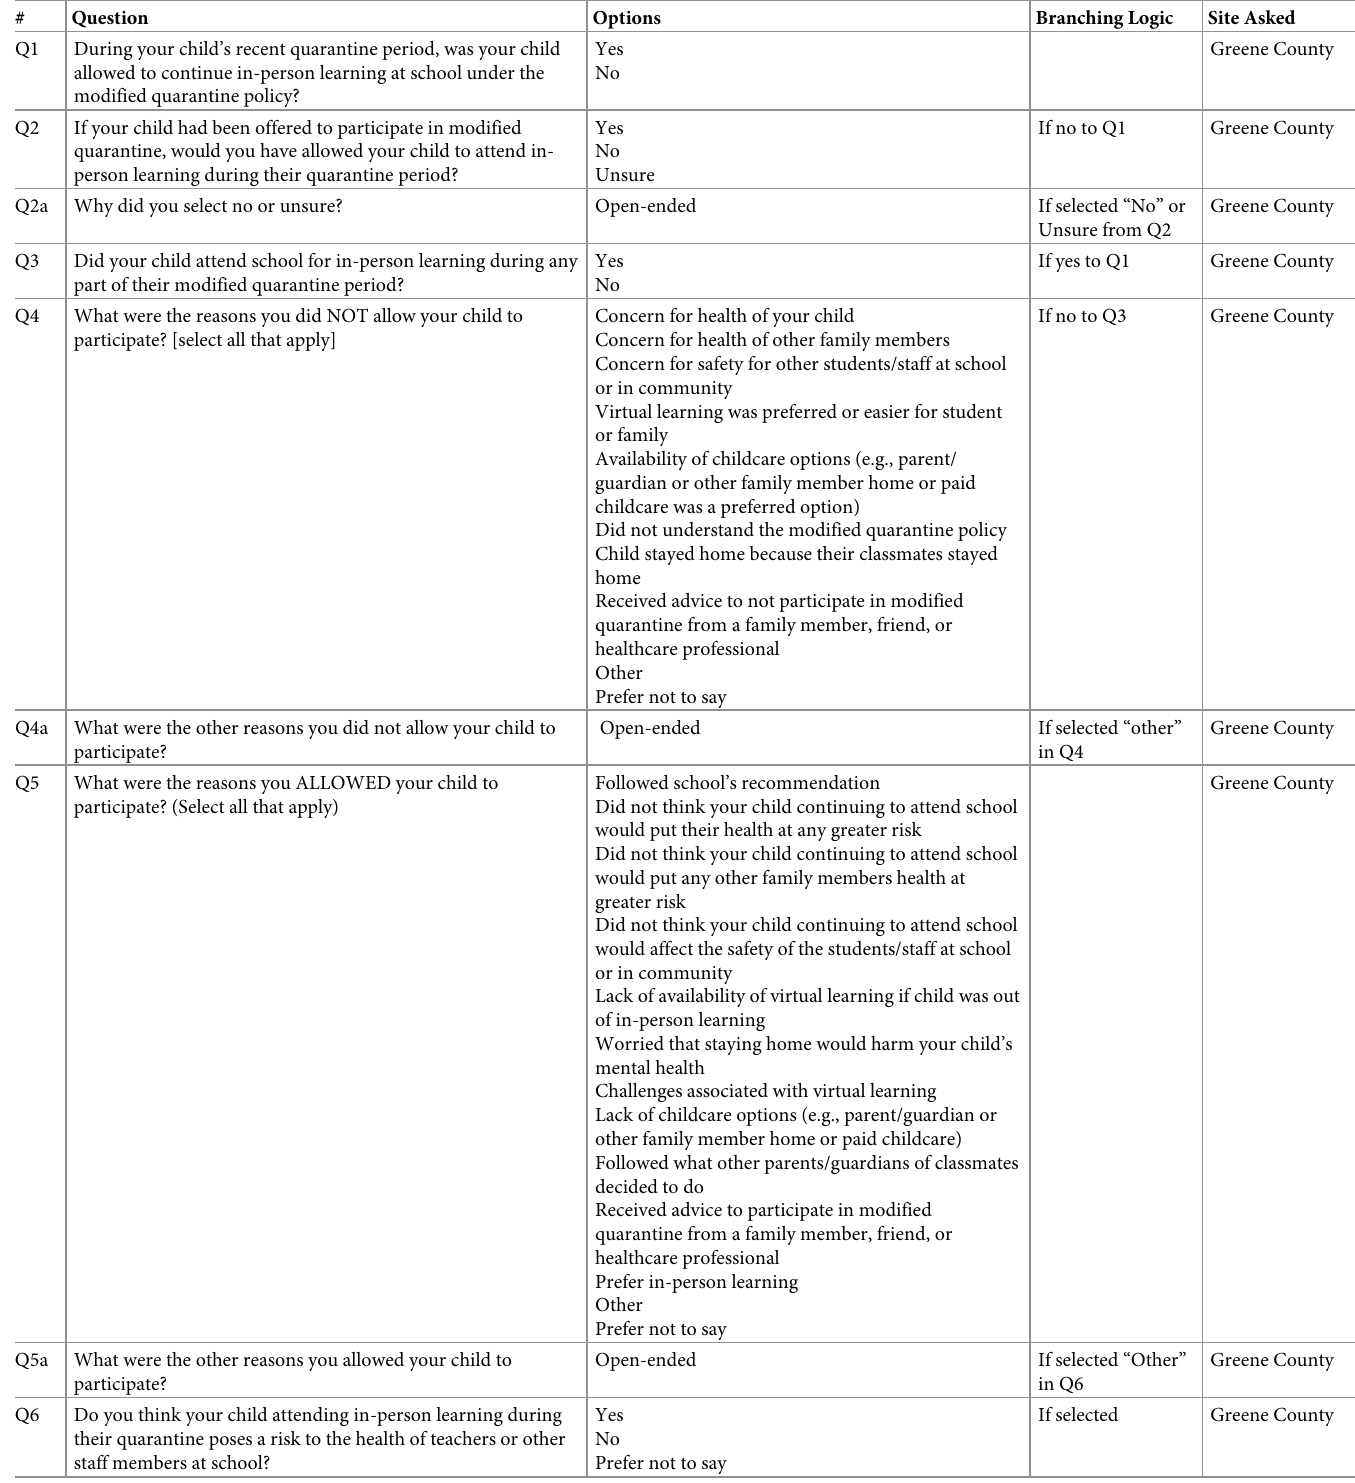
Table 1. Survey questions and response options for parents/guardians of students participating in modified and standard